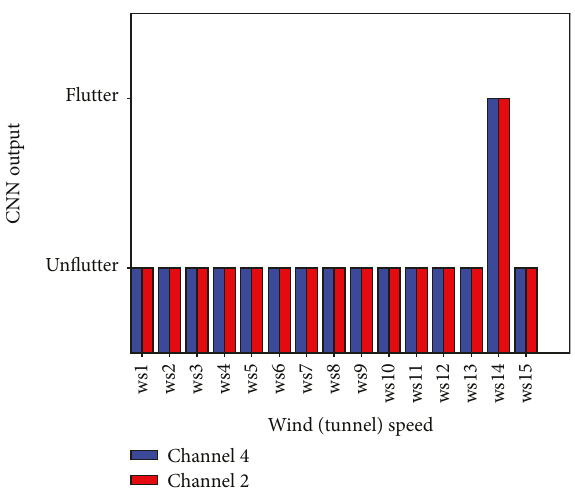
Figure 12: Symmetrical structures in no- fl utter test dataset. Figure 11; similar demarcations are made for the right and